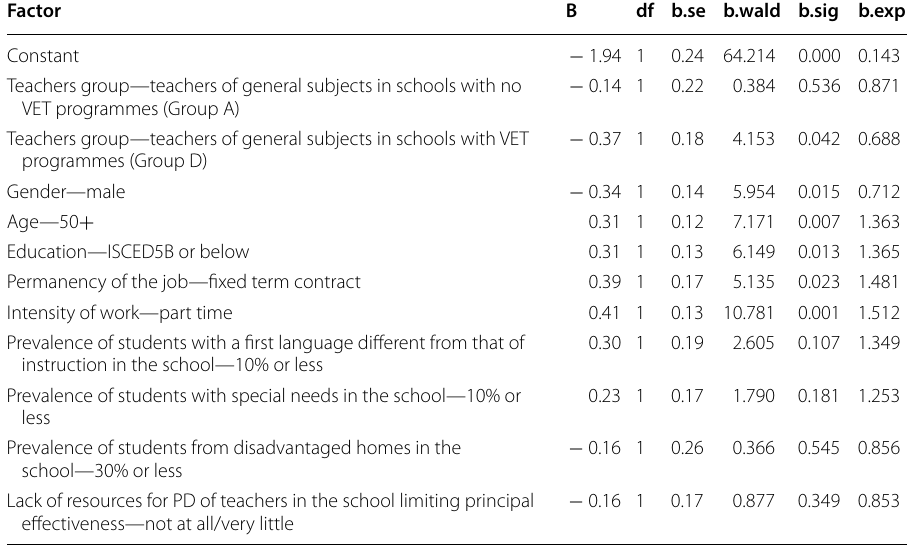
Table 18 Declaring lack of pre-requisites as a barrier to professional development, results of the logistic regression model, regressors R1–R10, Italy, 2013 (Source: Author’s calculations based on OECD, TALIS